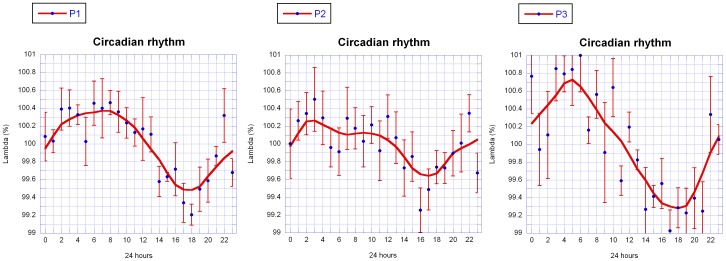
Daily change of Lambda of a mistletoe berry (mean ± SE) for three independent measurements (P1, P2, P3).Data from Fig. 9 were normalized for each day and averaged. P1 and P2 are two independent measures by the same person, P3 are measurements by a different person. The smooth continuous lines are LOWESS fits (P = 30%).